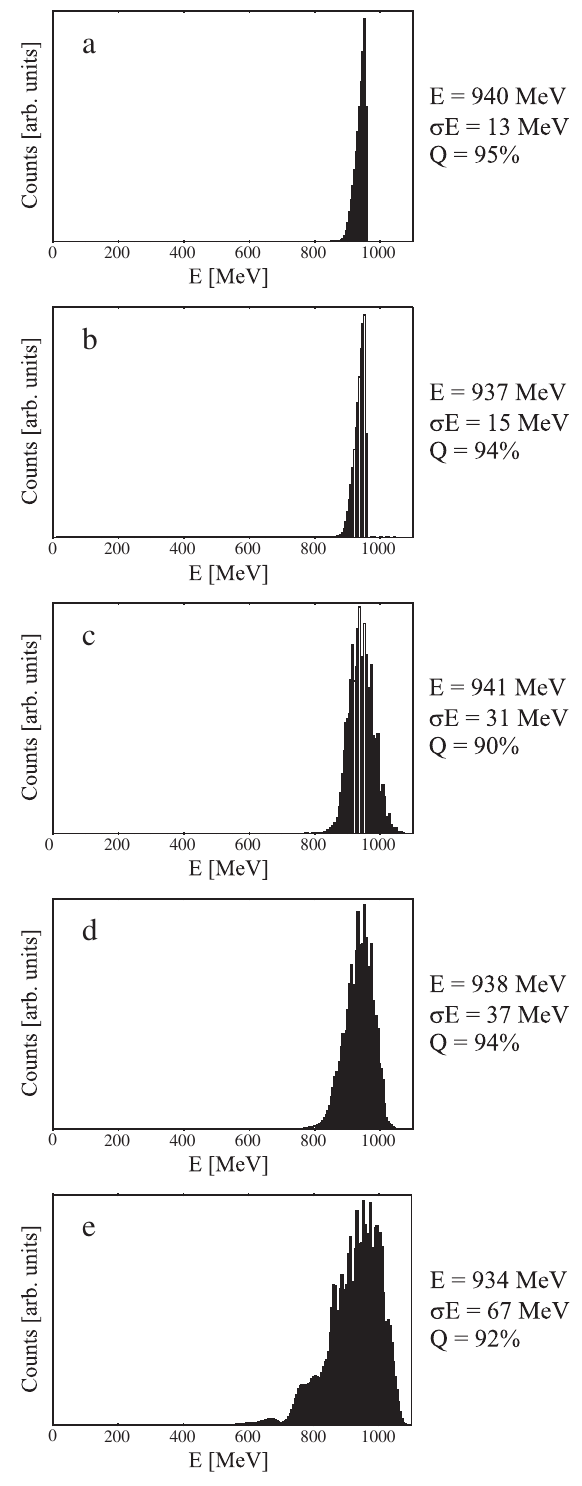
FIG. 15. Energy spectra of the accelerated bunch for a multi- shot experiment for a 0 ¼ 1 : 02 with injection 300 fs in front of the laser pulse under the following conditions: (a) design settings (Table V), (b) timing variation with (cid:5) energy with (cid:5) laser ¼ 5% , (d) plasma density variations with ¼ 5% , and (e) plasma density variations with (cid:5) (cid:5) n e